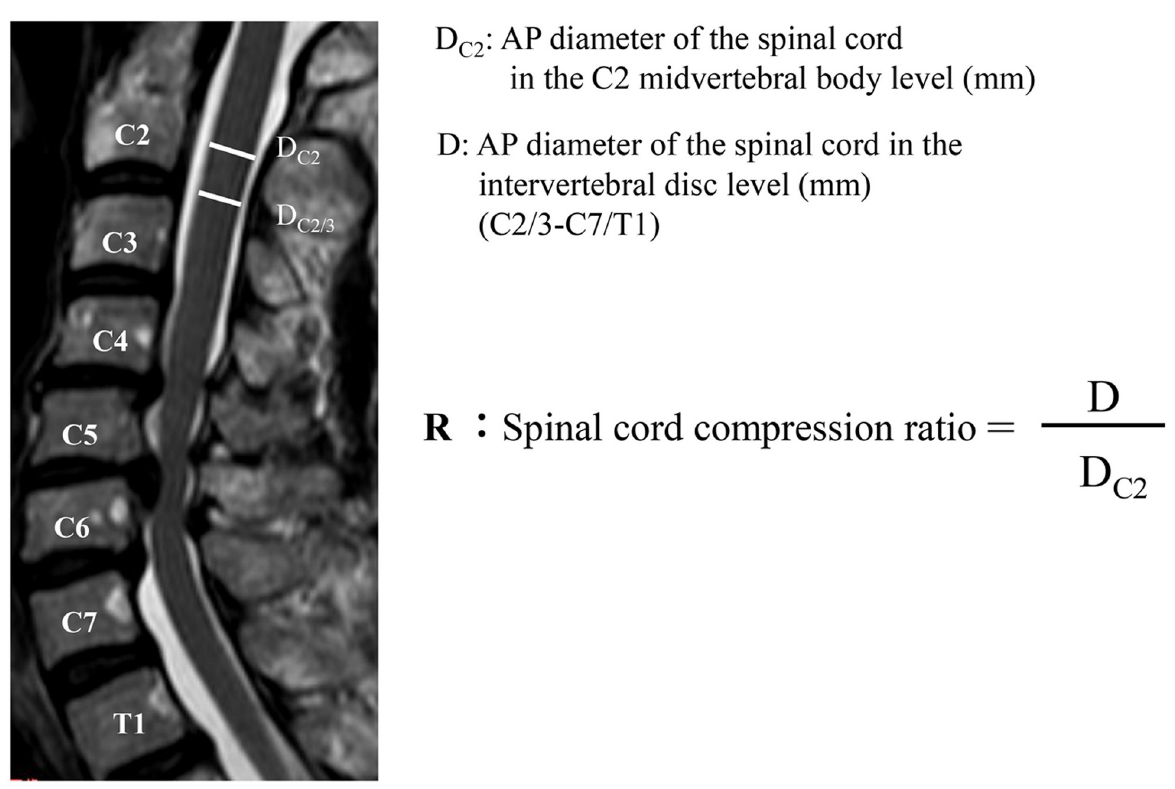
Fig 1. Evaluation of spinal cord compression. The spinal cord compression ratio (R) is used to evaluate the magnitude of cord compression. D C2 : AP diameter of the spinal cord in the C2 midvertebral body level (mm). D: AP diameter of the spinal cord in the intervertebral disc level (mm) (C2/ 3-C7/T1). AP: